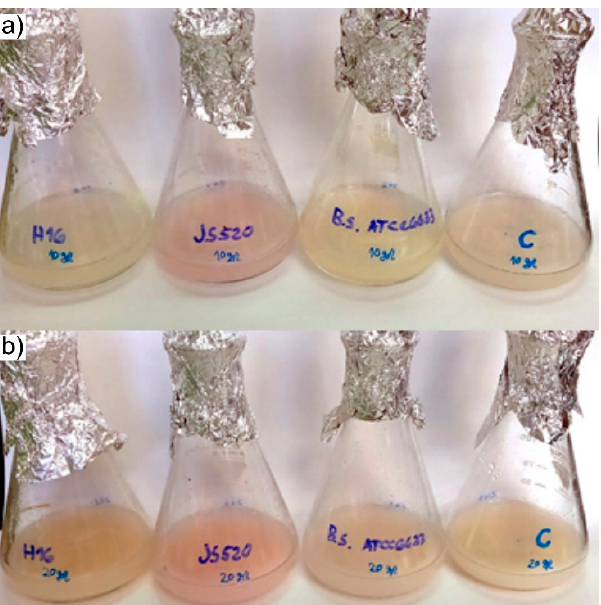
Figure 4. Cultures of Ralstonia eutropha H16, Streptomyces sp. JS520, Bacillus subtilis ATCC6633, and uninoculated control (left to right) in MSM medium with dissolved PVA/TPS material as the sole source of carbon: ( a ) 10 g/L and ( b ) 20 g/L.